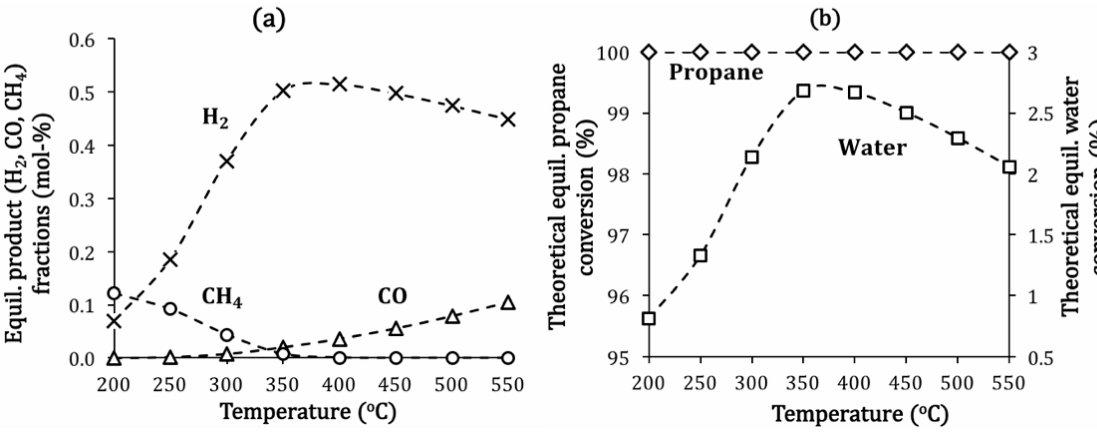
Figure 5. ( a ) Main mole fractions of H 2 , CO, and CH 4 ; and ( b ) theoretical reactant (propane and water) conversions as a function of reaction temperature (200 °C to 550 °C) at thermodynamic equilibrium conditions. Reactant feed: 500 vppm propane, 10 vol-% steam, 8 vol-% CO 2 , N 2 in